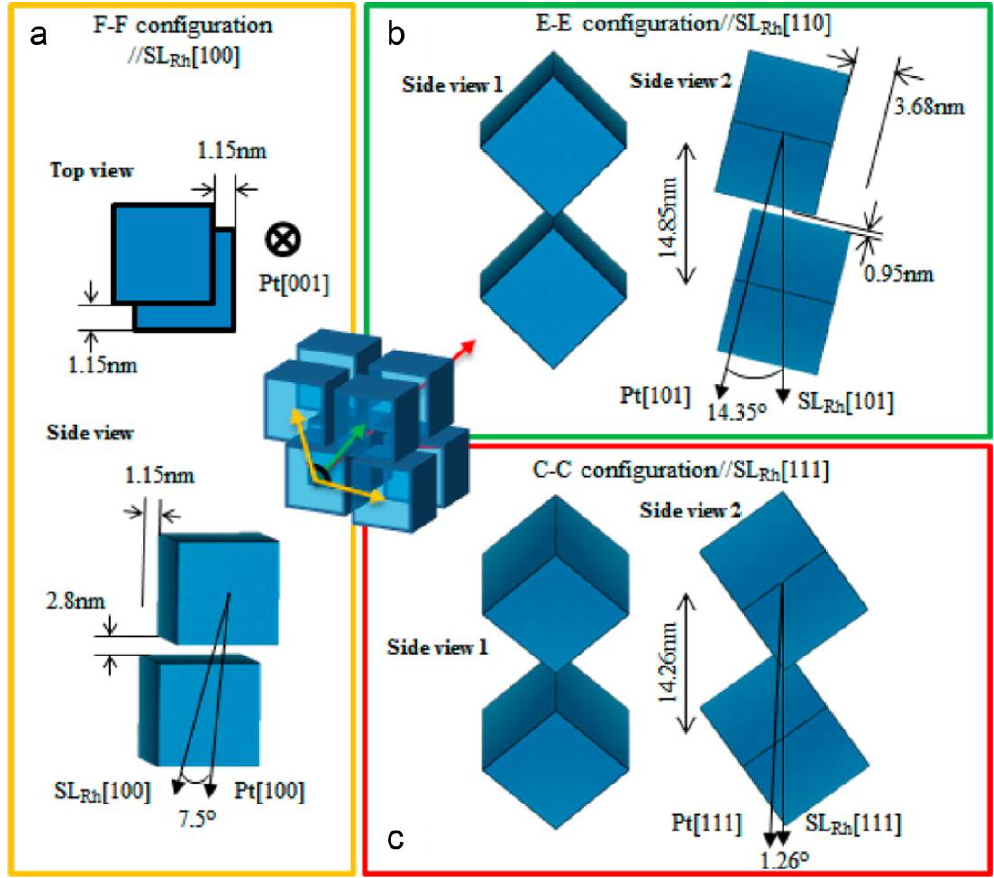
Figure 6. Packing configurations of cubic NCs and defined parameters of neighboring NCs in an obtuse rhombohedral (Rh) superlattice: ( a ) face-to-face, ( b ) edge-to-edge, and ( c ) corner-to-corner arrangements. Copyright of the American Chemical Society [38].